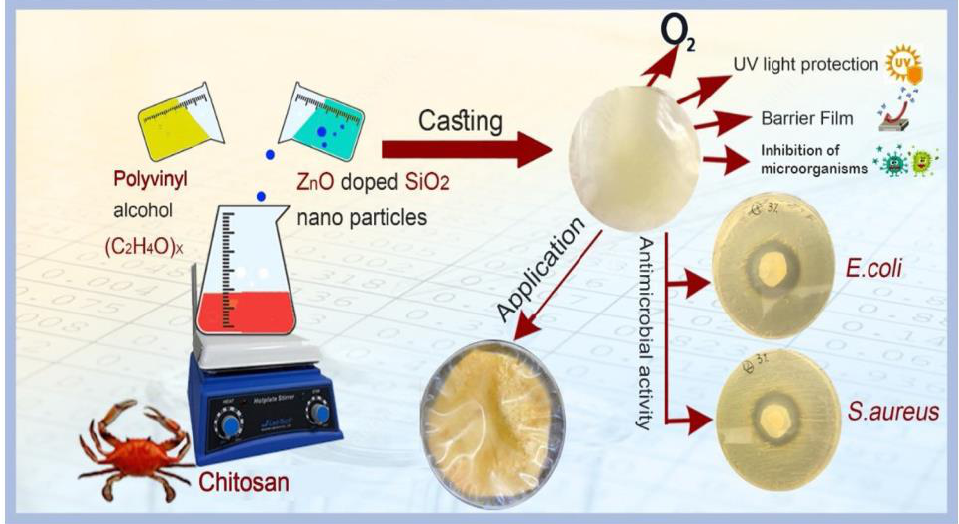
Figure 1. The preparation and utilization of PVA/CS/ZnO-SiO 2 bio-nanocomposite films for bread preservation [47].